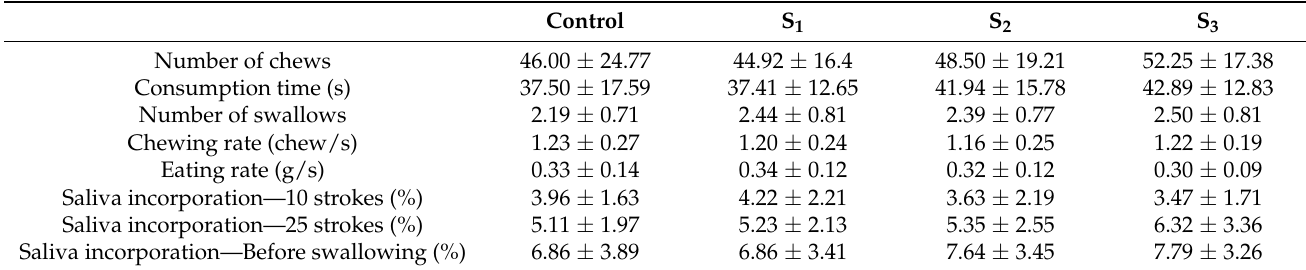
Table 2. Summary of the oral processing behavior parameters for samples prepared using three